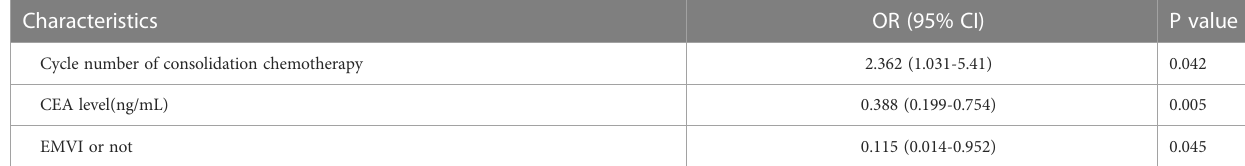
TABLE 2 Logistic multivariate analysis of pCR in LARC patients after nCRT. Characteristics